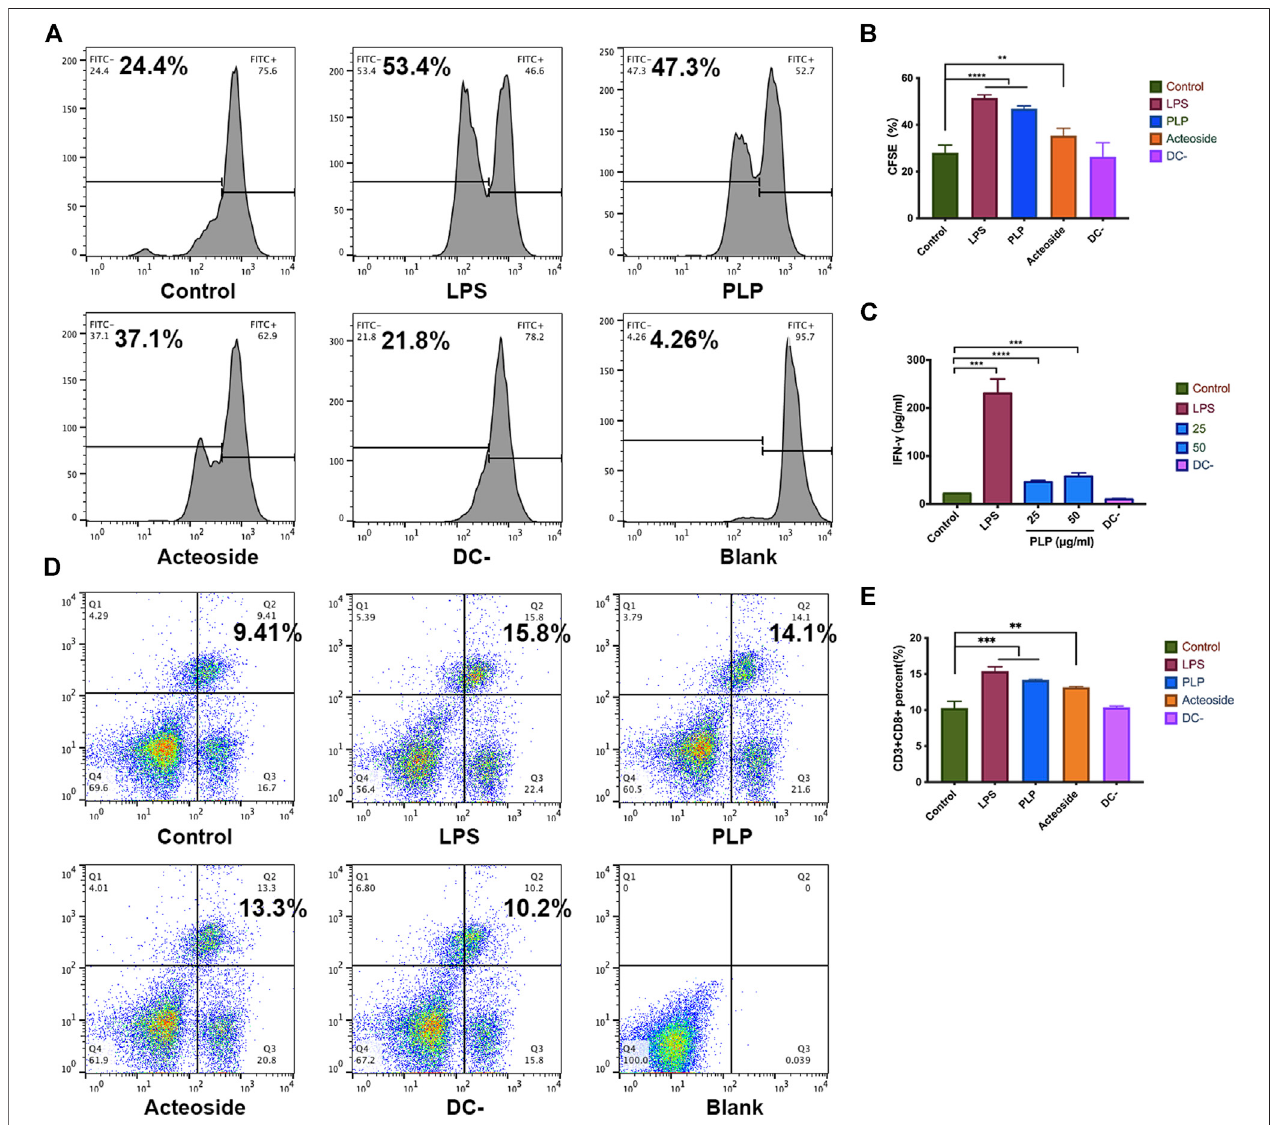
FIGURE 3 | PLP strengthened DCs to stimulate lymphocyte proliferation and CTL differentiation. (A, B) CFSE-labeled spleen lymphocytes were stimulated with DCs for 48 h. The fraction of proliferative lymphocytes was measured in a CFSE dilution assay. Representative examples are shown. (C) The concentration of IFN- γ secreted by splenic lymphocytes. (D, E) Phenotype analysis of CD3 + CD8 + T cells in the spleen. All values shown are the average values from three independent experiments ± SEM (* p < 0.05, ** p < 0.01, and *** p < 0.001).